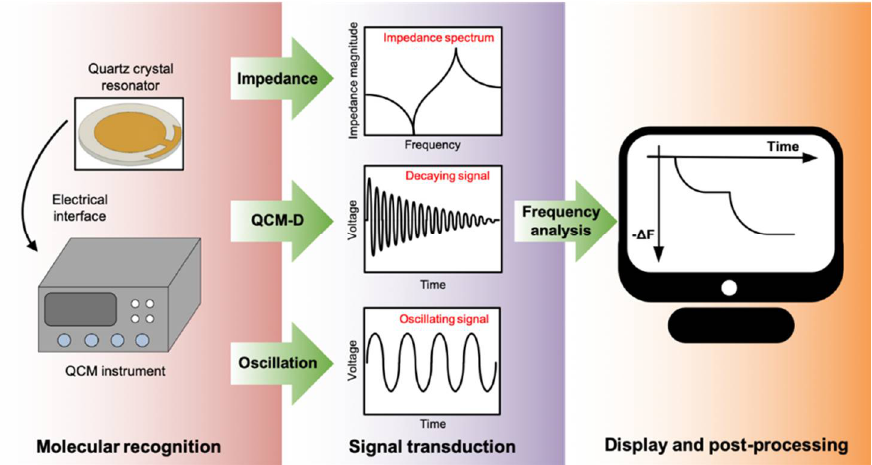
Figure 12. Brief concepts illustrating three different types of quartz crystal microbalance sensing instruments including impedance analysis, quartz crystal microbalance with dissipation monitoring (QCM-D), and oscillation-based measurements.